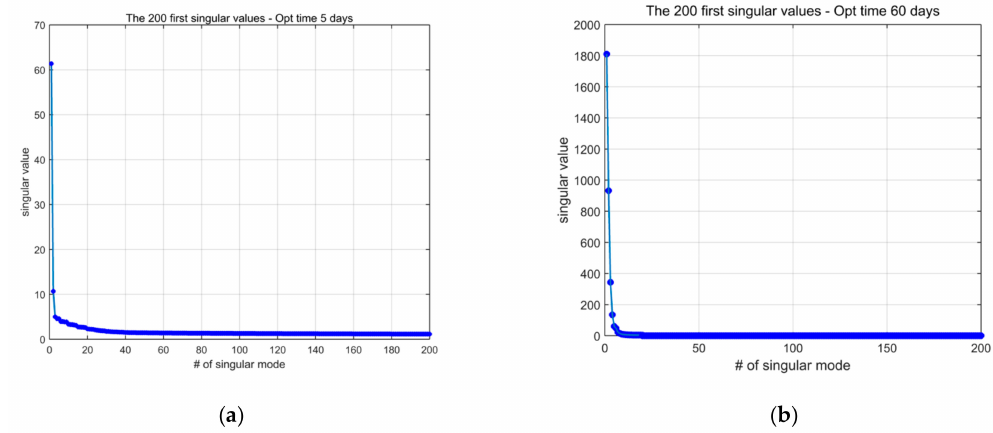
Figure 2. The 200 dominant singular values computed on an optimization time of 5 days ( a ) and an optimization time of 60 days ( b